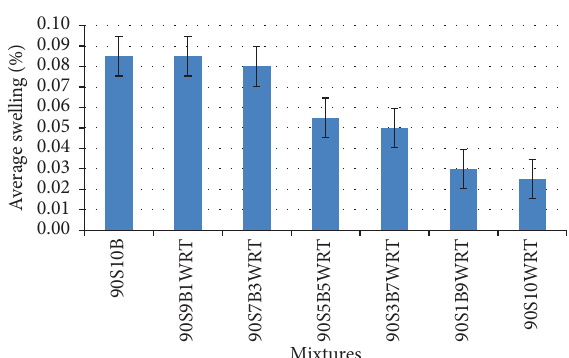
Figure 9: Te results of free swelling tests.